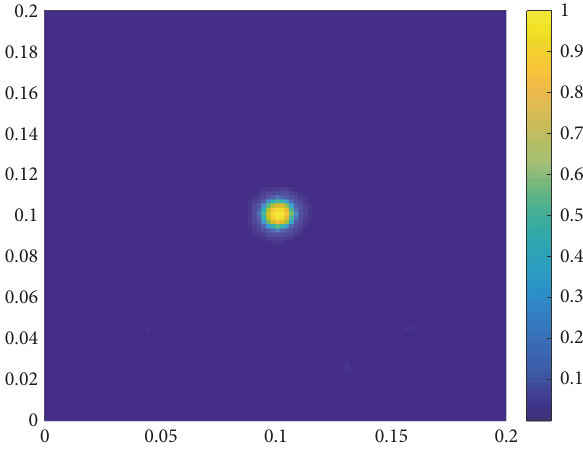
Figure 5: Single circular metal defect inversion